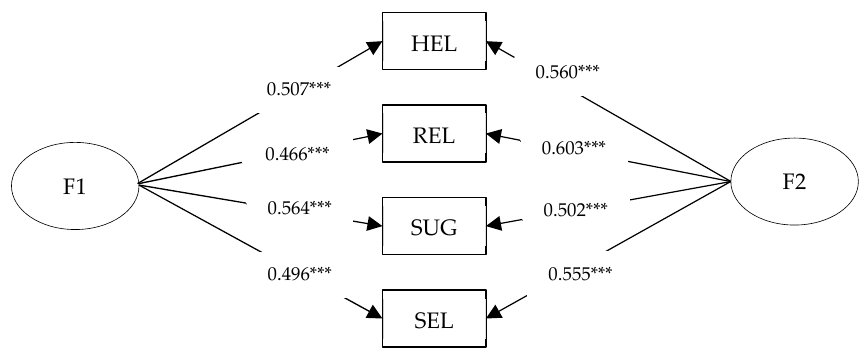
Figure 4. Different effects of social motivation/individual motivation. Among them, F1 is social safety capital and F2 is autonomous security motivation. *** At the 0.001 level, the correlation is significant. HEL is mutual aid among workers; REL is the relationship between superior and subordinate; SUG is participation of suggestion-making; and SEL is self-control.